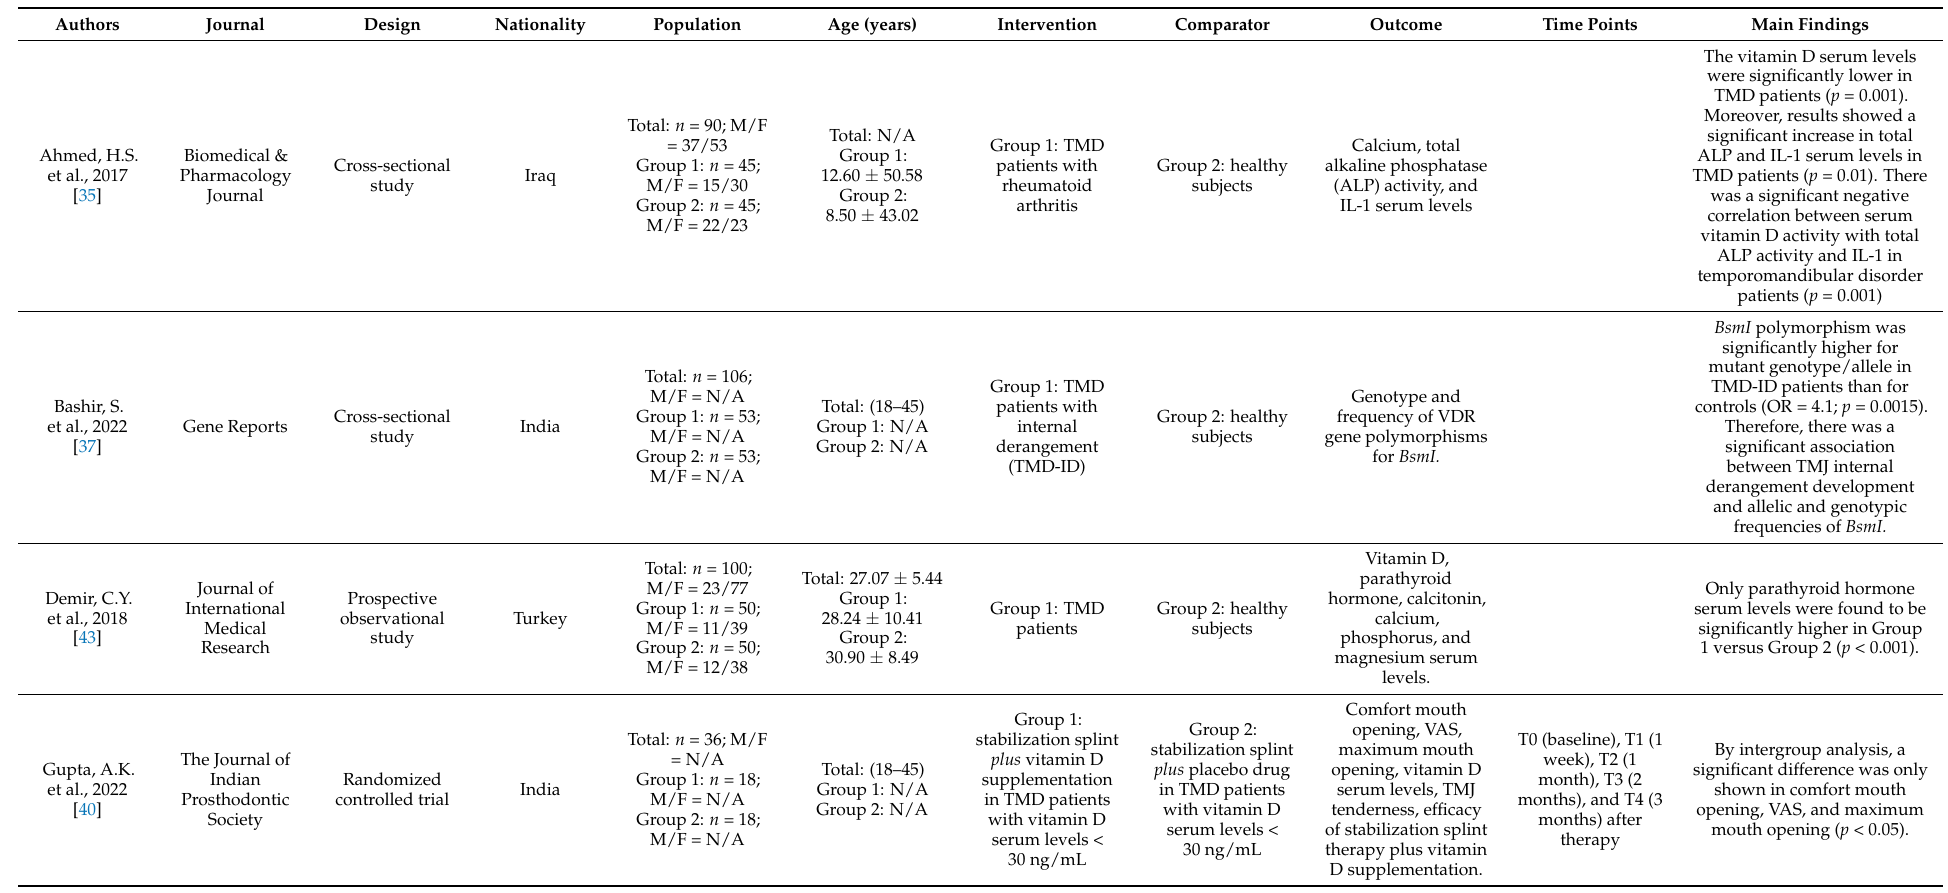
Table 2. Main characteristics of the studies included in the present systematic review.